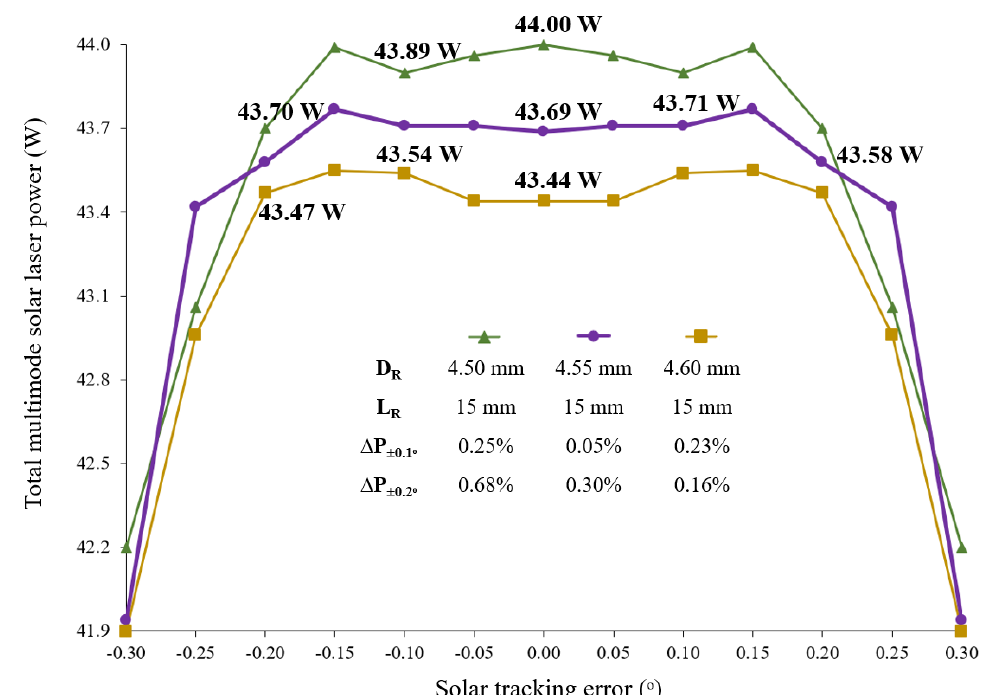
Figure 7. Total multimode solar laser power for the four-rod scheme as a function of the solar tracking error, ranging from the optimal alignment (0.0°) to 0.30° for D R = 4.50 mm, 4.55 mm and 4.60 mm. The variation in total multimode laser power at ±0.1° solar tracking error ( ∆ p ±0.1° ) and ±0.2° solar tracking error ( ∆ p ±0.2° ) were presented for each D R .